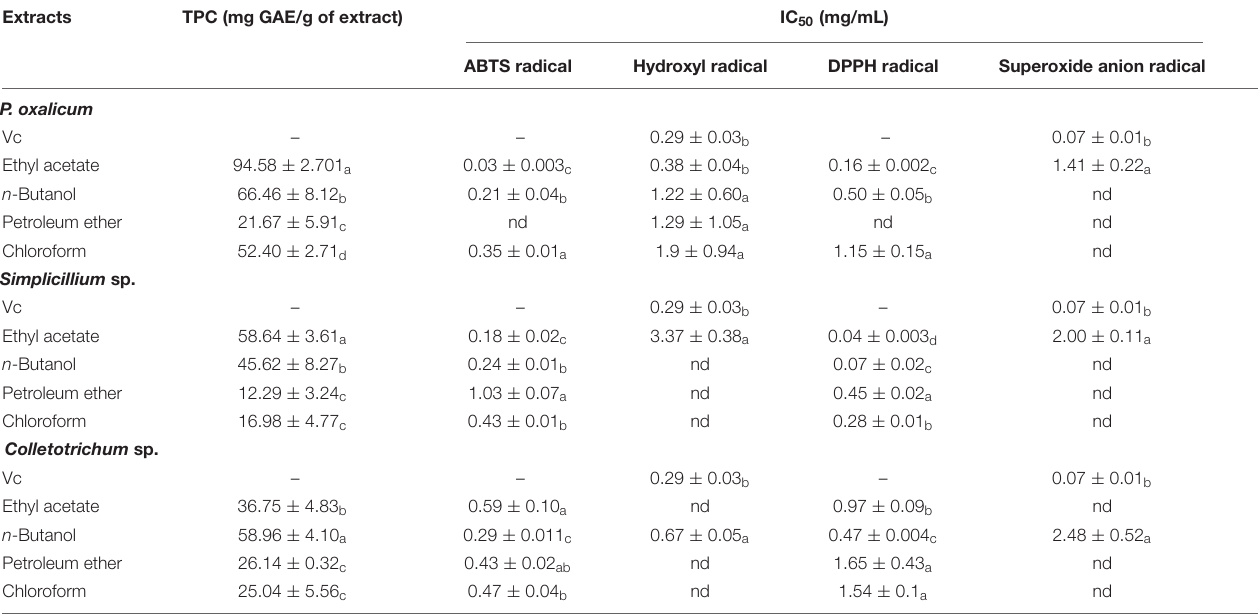
TABLE 3 | Assessment of TPC and antioxidant activity of P . oxalicum , Simplicillium sp., and Colletotrichum sp. extracts. Extracts TPC (mg GAE/g of extract)